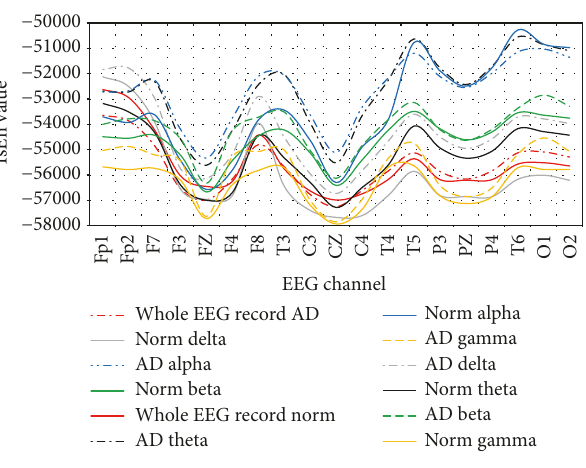
Figure 2: EEG biomarkers for TsEn.